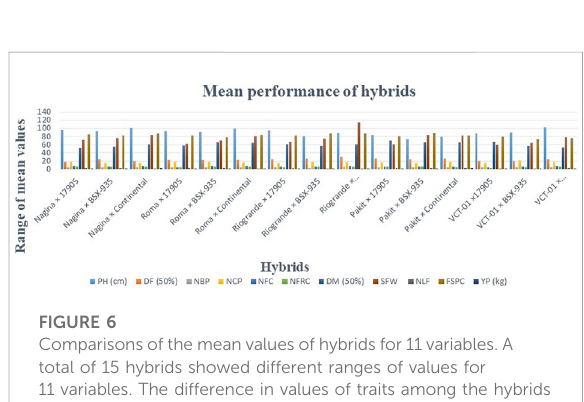
FIGURE 5 Comparisons of the mean values of parents for 11 variables. A total of eight parents showed different ranges of values for 11 variables. The difference in values of traits among the parents indicated the scope of selection.